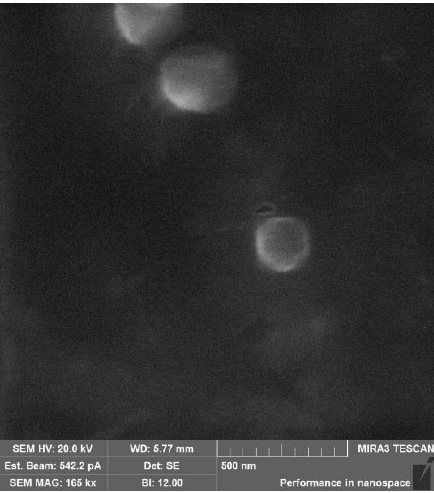
Figure 4. SEM images of the succinyl chitosan-colistin conjugates (SucCS-CT-10).